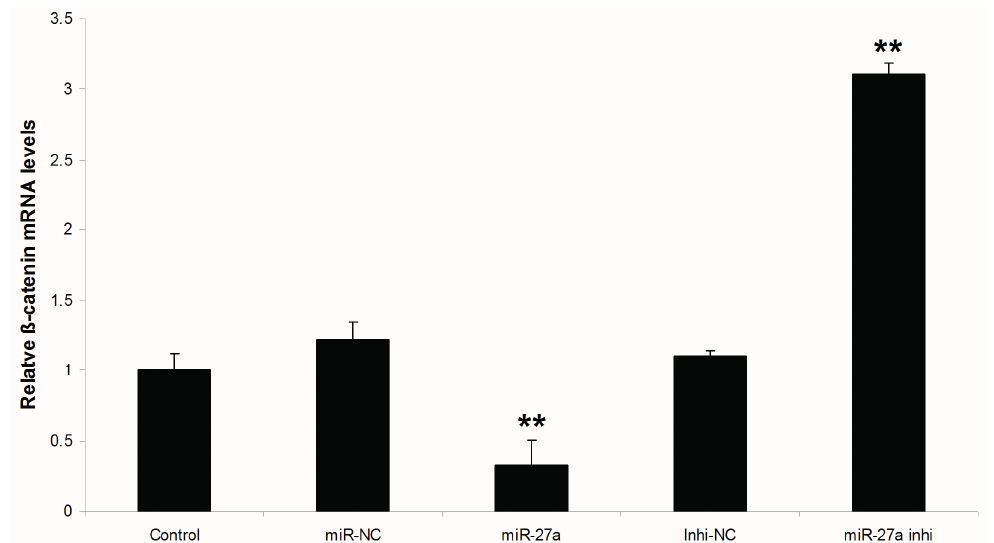
Figure 5. Expression levels of β -catenin mRNA in melanocytes transfected with miR-27a mimic or inhibitor as well as their controls. Treated cells were divided into 5 groups: miR-NC, miR-27a, Inhi-NC, miR-27a inhi and untransfected control. Values represent the mean ± SE from four independent experiments. ** p <